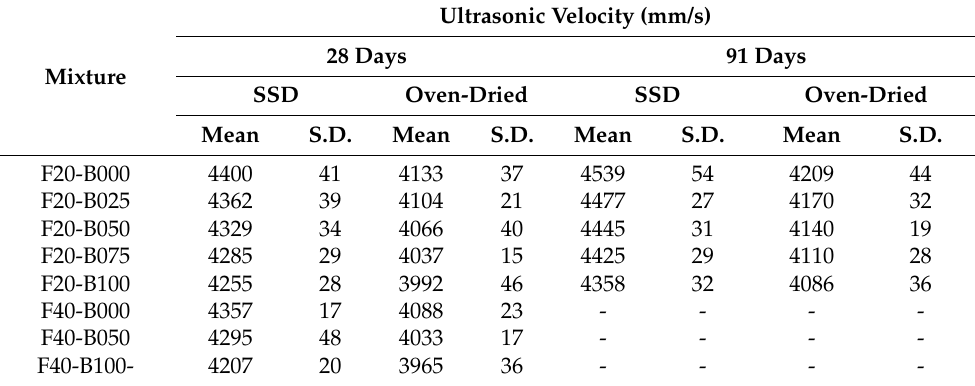
Table 6. Ultrasonic velocity